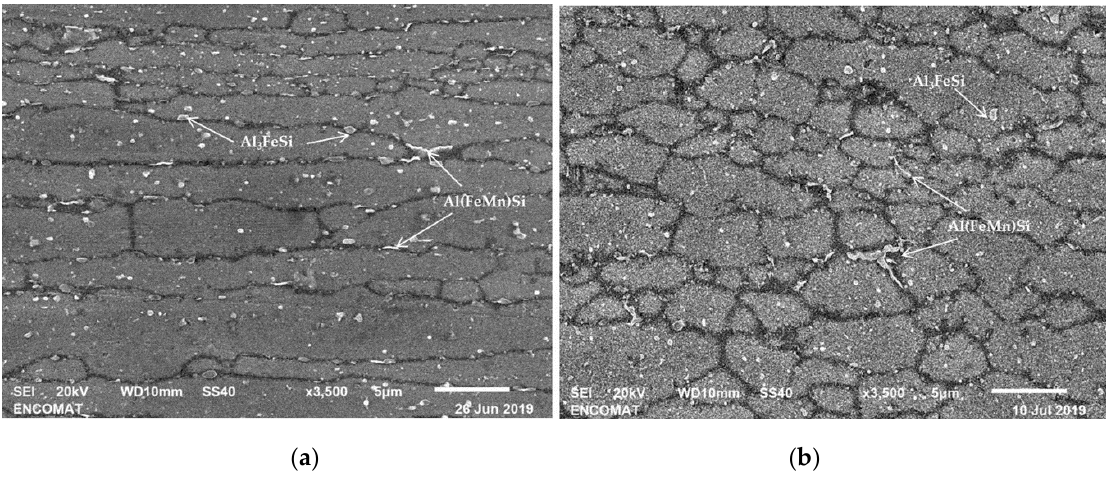
Figure 5. SEM micrographs of the profiles extruded: ( a ) Longitudinal sections and ( b ) transversal sections at extrusion direction.